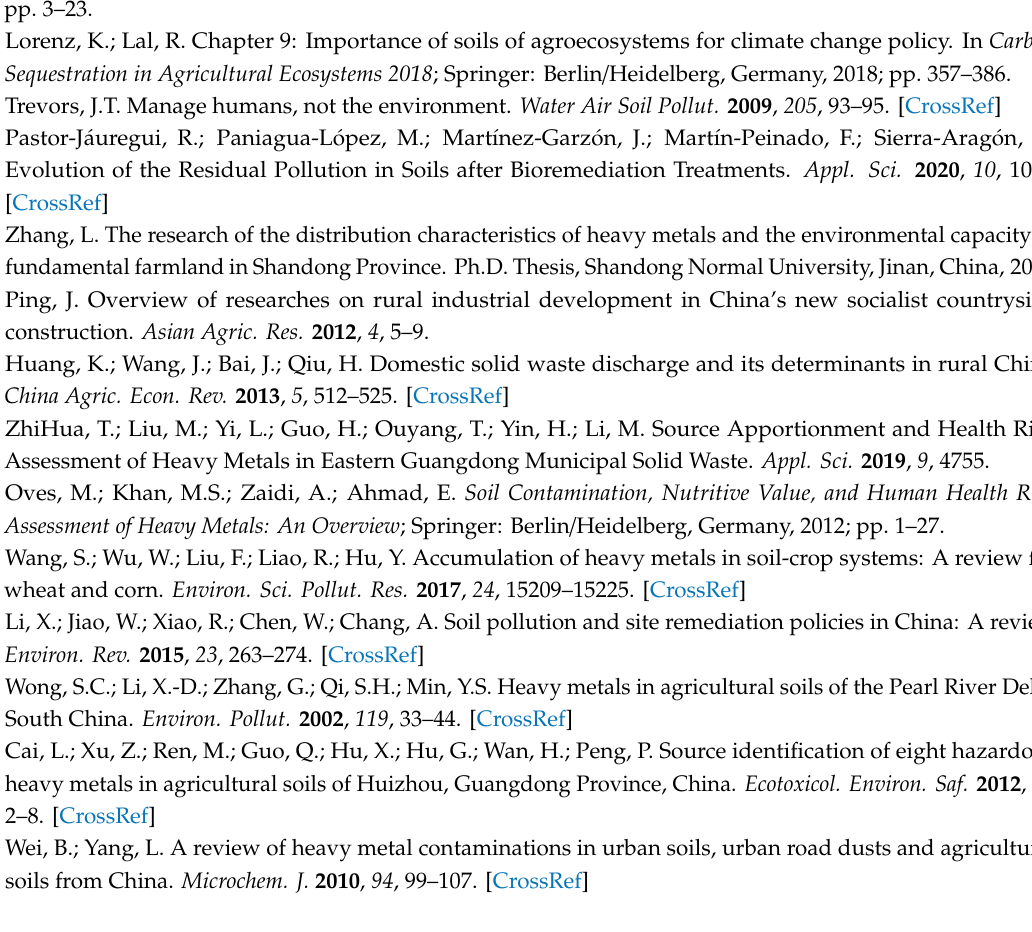
Table S1: The longitude and latitude of the total sampling sites in Shandong Province. Table S2: The websites of cities’ yearbooks in the statistical bureau. Table S3: The retrieved economic indicators from cities’ yearbooks during 2017